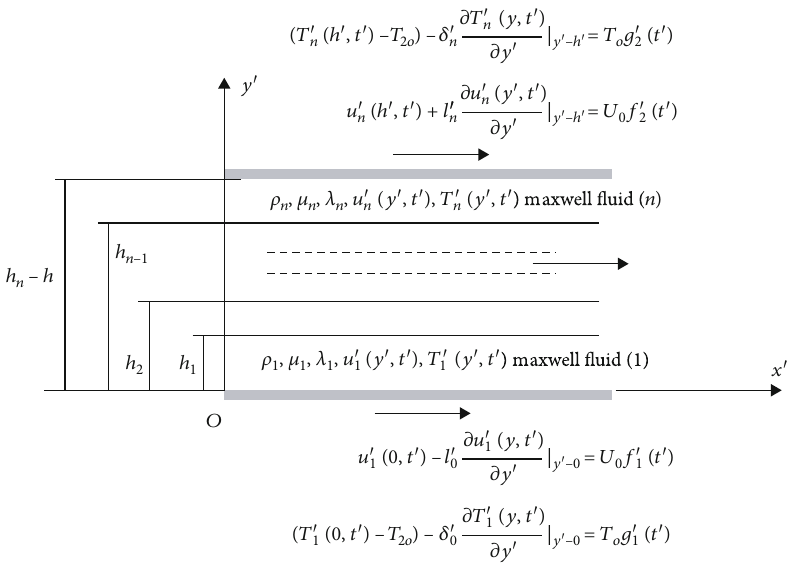
Figure 1: Geometry of the